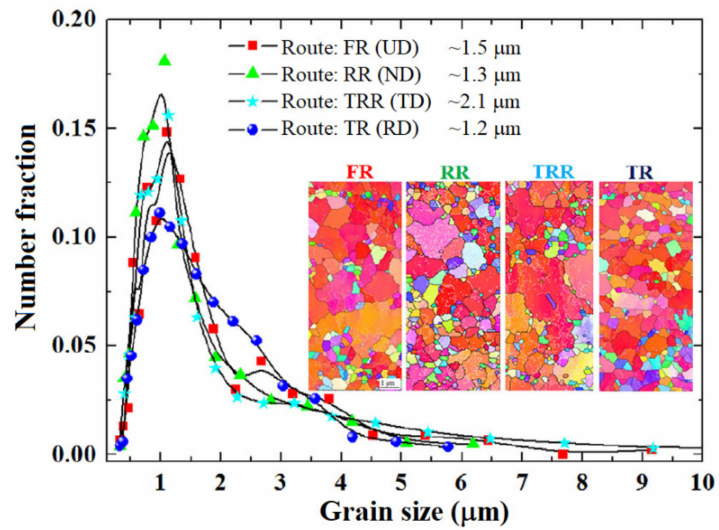
Figure 31. Grain size distributions and average grain sizes of the AZ31 Mg alloy samples deformed by differential speed rolling using the different deformation routes (thickness reduction from 4 mm to 1 mm by two passes, speed ratio S R = 4.0), reproduced from [85], with permission from Elsevier,